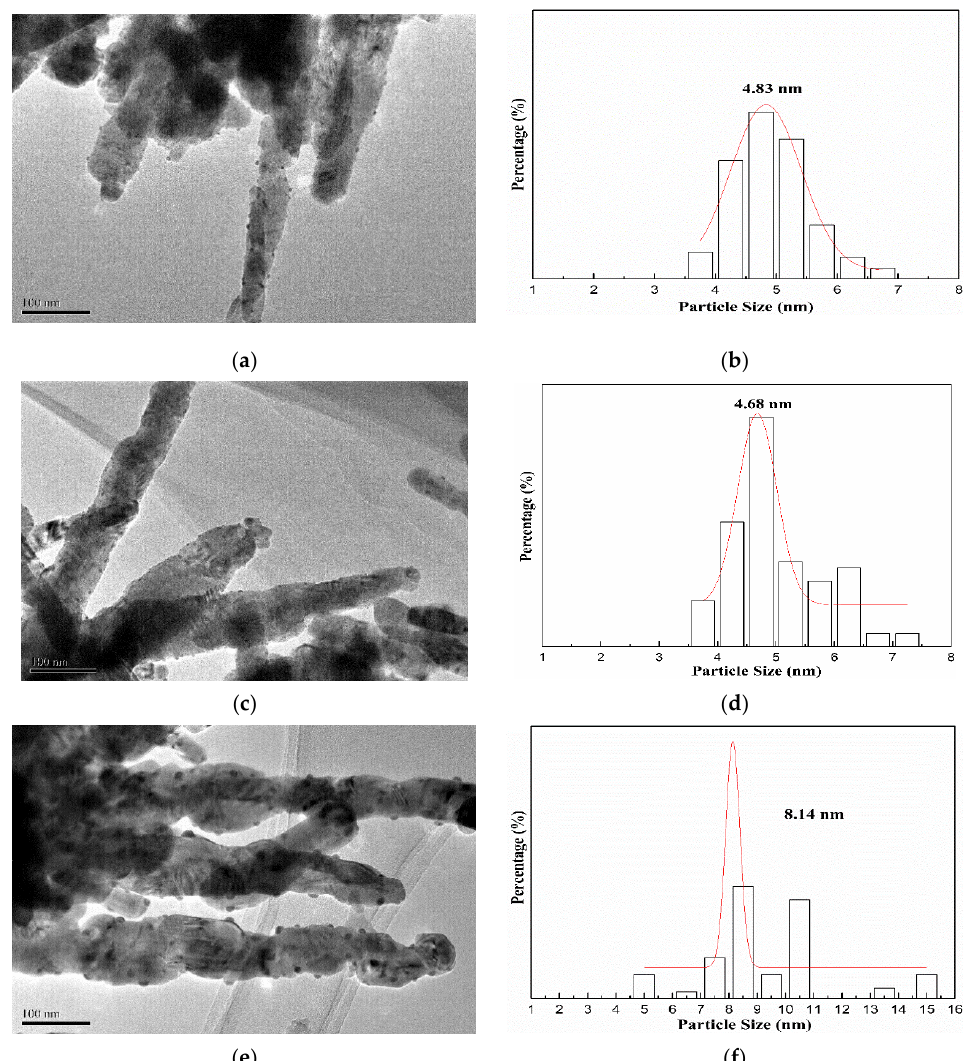
Figure 4. Size distribution histograms and TEM images of Au 0.5 /CuO-300 ( a , b ), Au 1.0 /CuO-300 ( c , d ), Au 1.5 /CuO-300 ( e , f ).